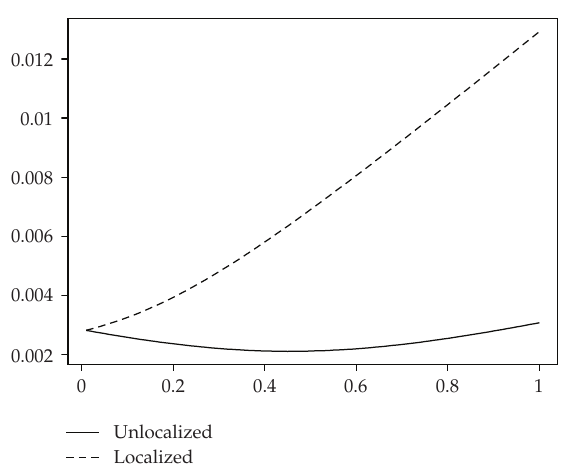
Figure 1: Localized and Unlocalized